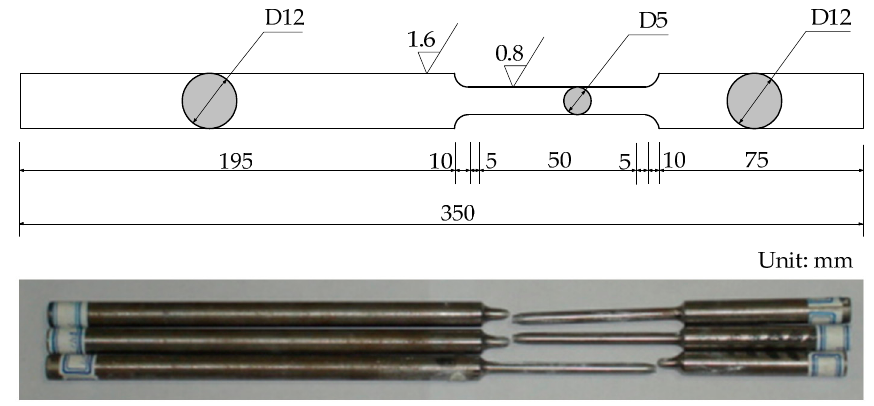
Figure 1. Specimen geometry. Table 1. Chemical composition (wt.%) of the four rebar grades.